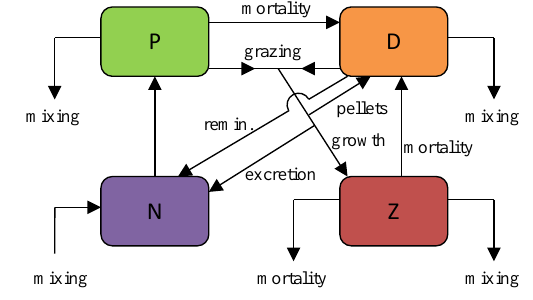
Figure 4. Structure of the NPZD